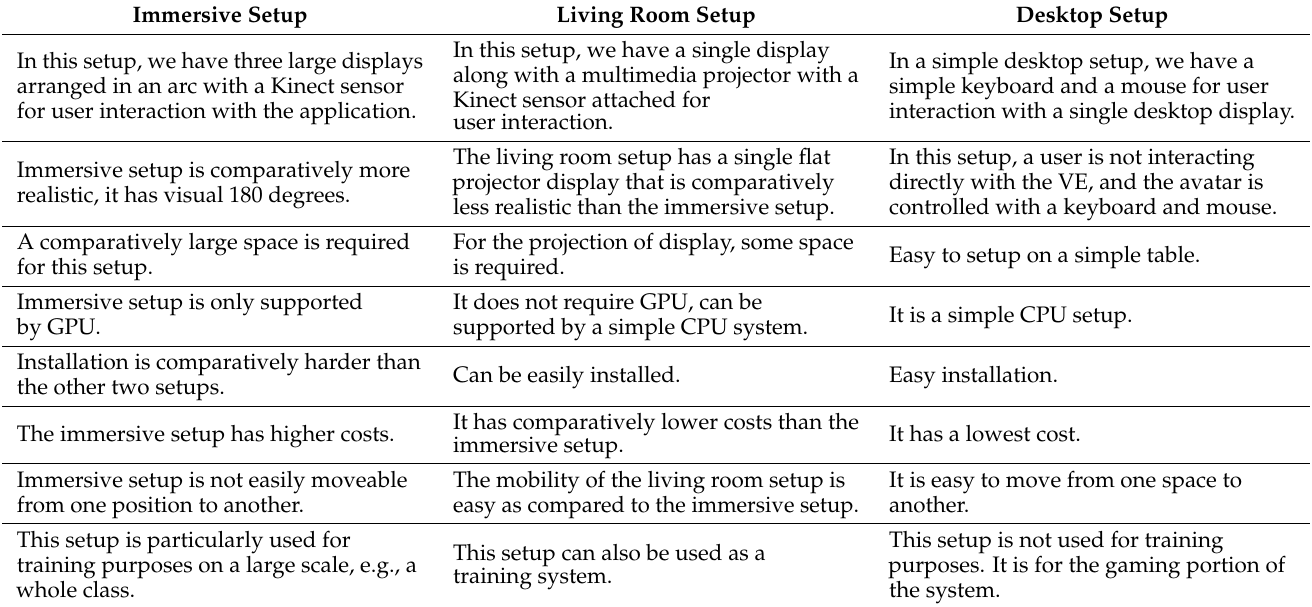
Figure 6. Different VR training system interface setups. Table 1. Comparing different setups of our proposed